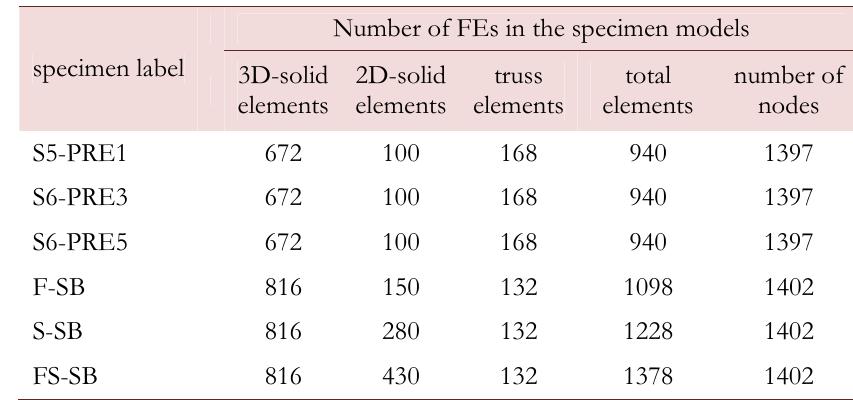
Table 5: Number of FEs for the analysed specimens.